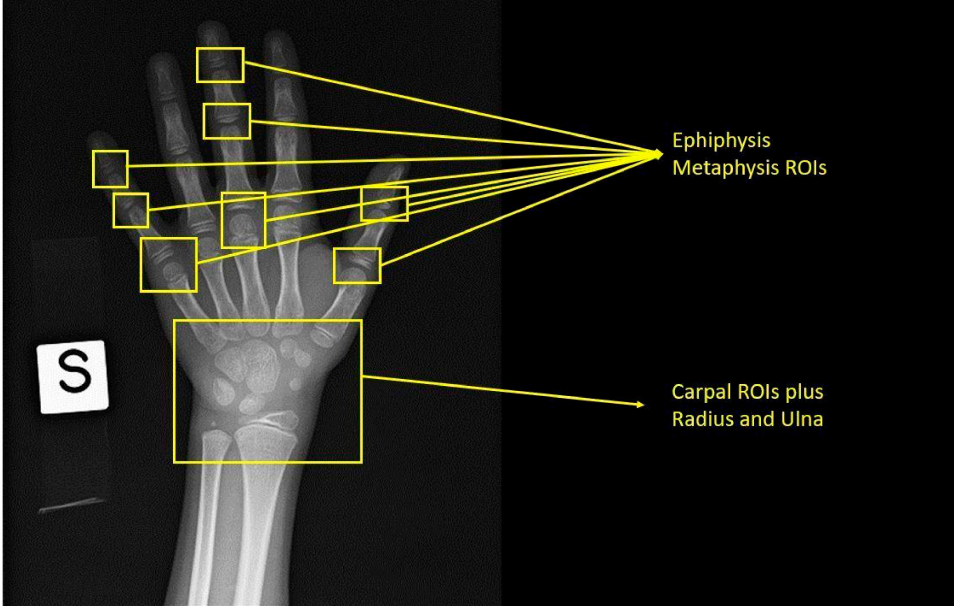
Figure 1. Tanner Whitehouse Method (TW2) with a demonstration of the region of interest that should be placed for age calculation.